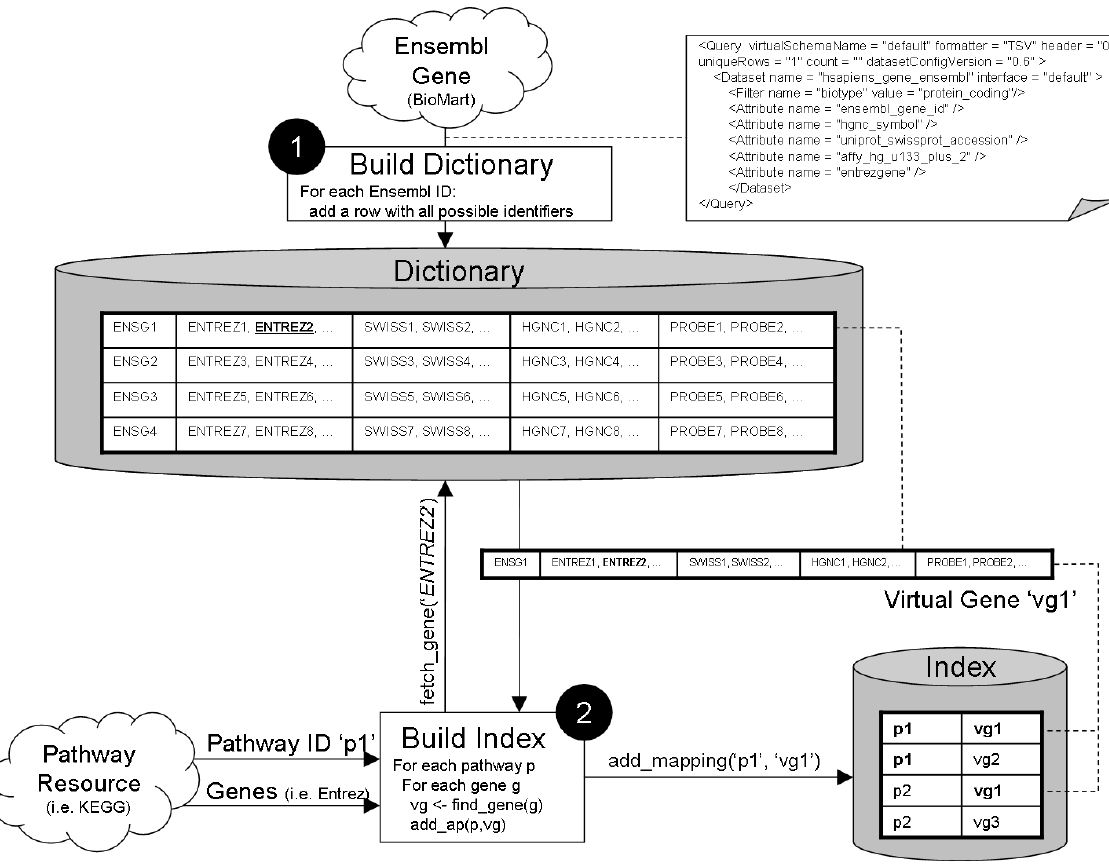
Figure 1: PathJam Dictionary containing virtual genes. Different namespaces are integrated through the aggregation of different identifiers belonging to the same virtual gene.